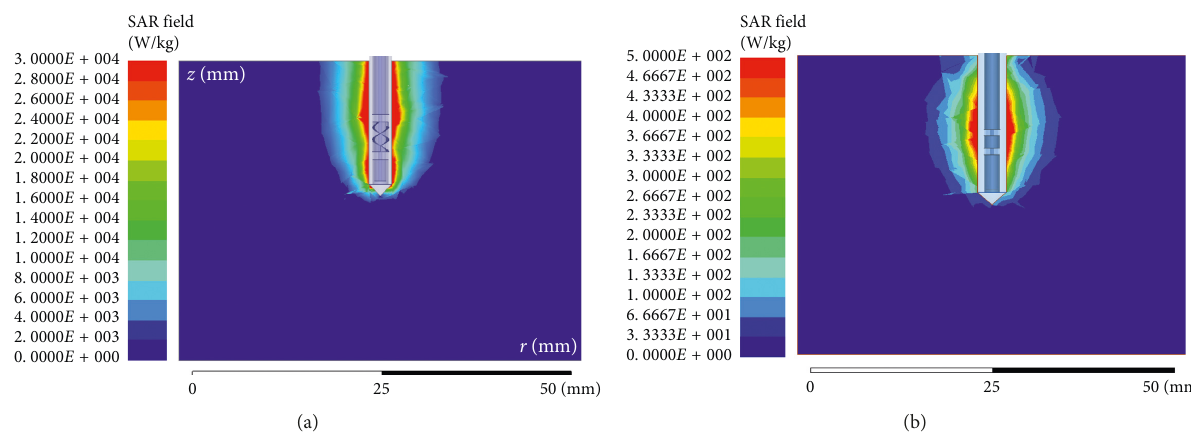
Figure 5: The result of the SAR pattern for the steady state: (a) antenna with the helical slot part and (b) antenna without the helical slot part.